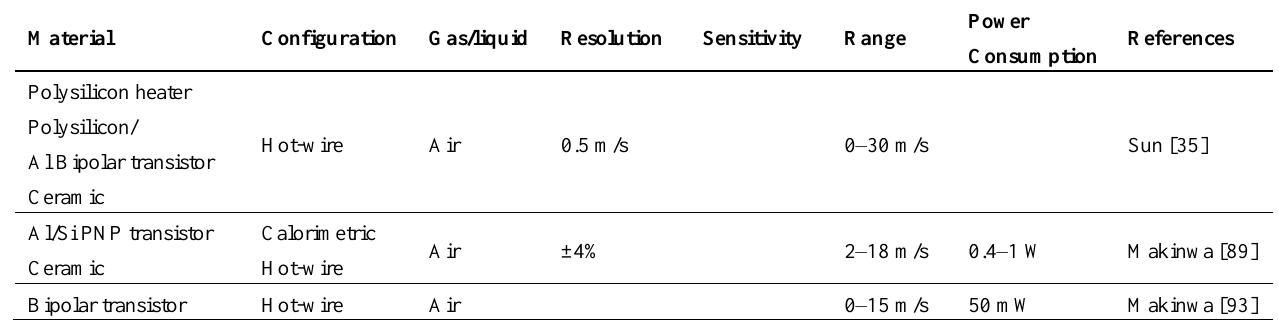
Table 5. Thermoelectronic flow sensor feature